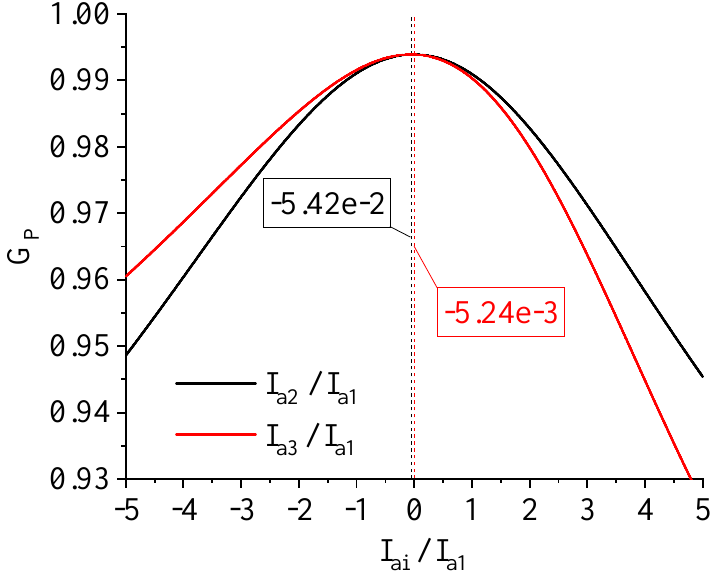
Figure 10. Case 2: efficiency calculated for Case 2 by varying the ratio of the input currents while all the other parameters are set to the optimal